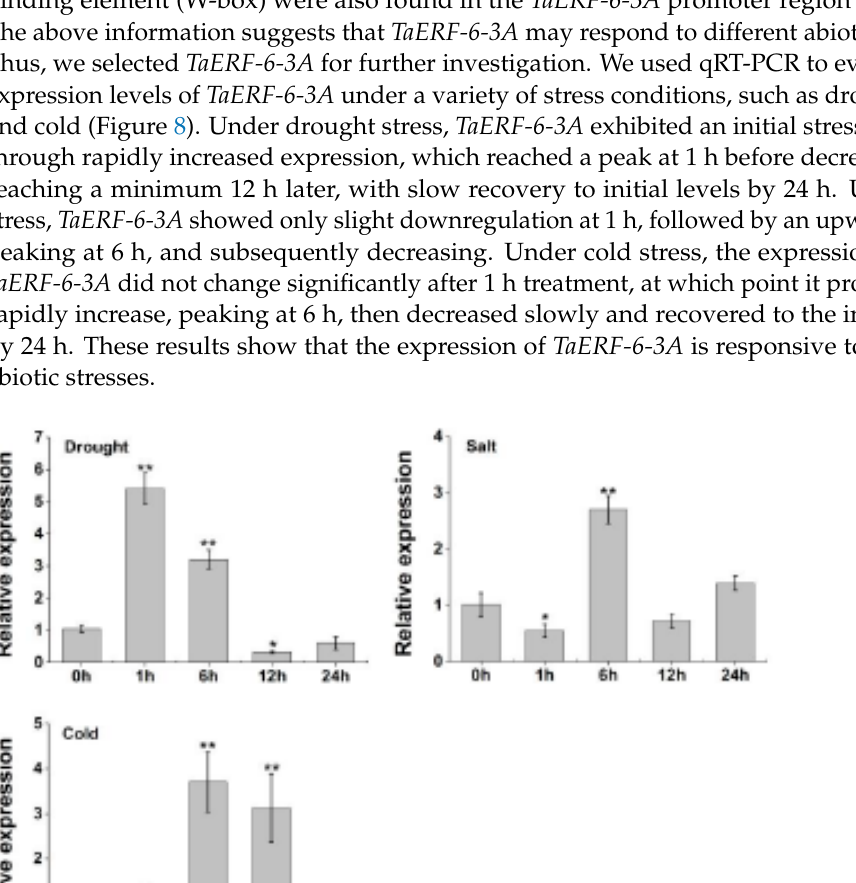
Figure 7. Transcriptional activation of five TaAP2/ERF proteins. The ORF fragments of TaAP2/ERF genes were ligated with pGBKT7 to construct a fusion vector. The yeast cells harboring TaAP2/ERF fusion vectors were cultured on the SD/-Trp and SD/-Trp/-His/-Ade.